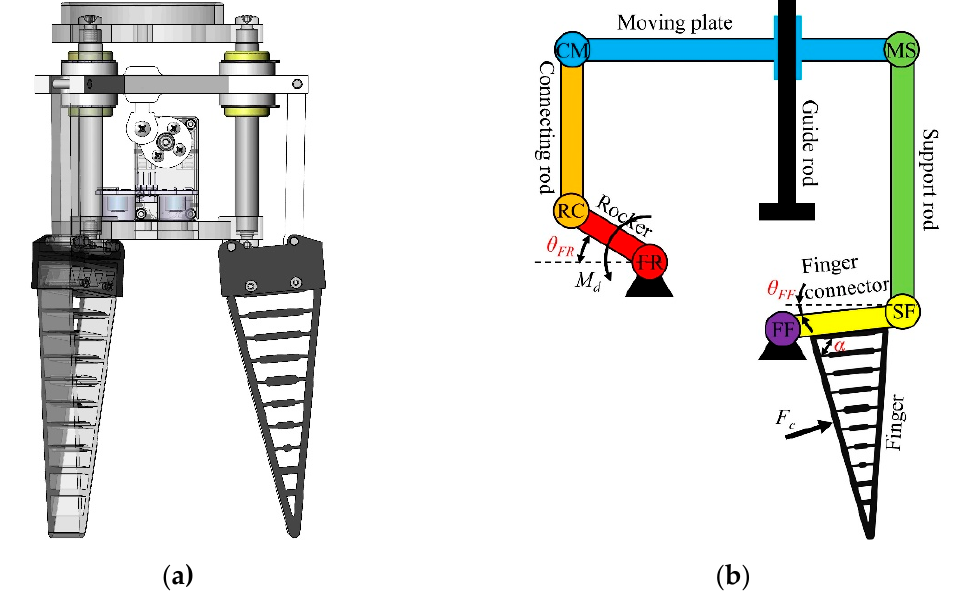
Figure 5. Motion schematic of the gripper: ( a ) physical model; ( b ) kinematics model. In the figure: M d is the servo output torque; θ FR is the angle between the rocker and the horizontal direction; θ FF is the angle between the finger connector and the horizontal direction; α is the angle between the front and rear beams of fingers and the base.